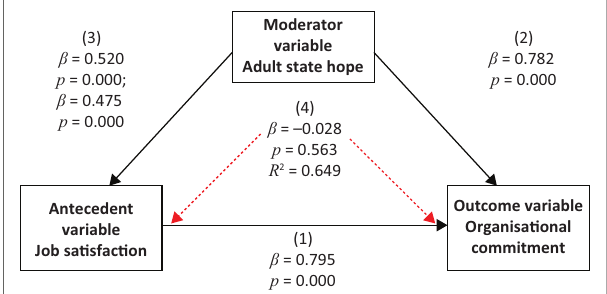
Antecedent variable Job sa(cid:15)sfac(cid:15)on FIGURE 1: Moderation analysis between job satisfaction, adult state hope and organisational commitment.